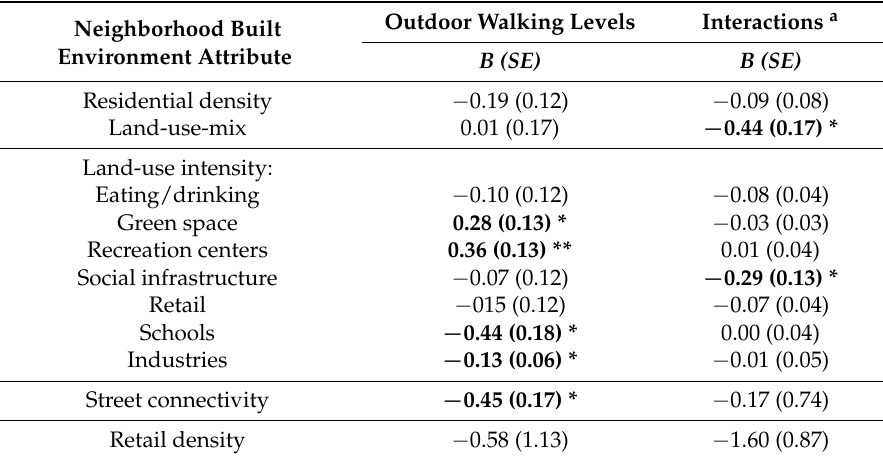
Table 6. Results of hierarchical analyses: relationships between neighborhood built environment attributes and outdoor walking